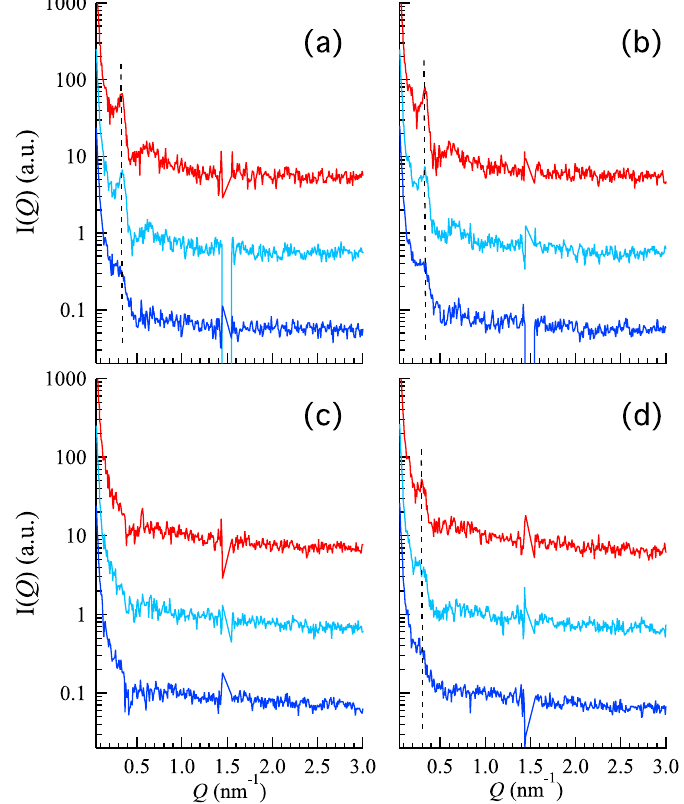
Figure 3. Small angle X-ray scattering (SAXS) di ff raction profiles of P ( a ); P-CA ( b ); P-HA ( c ); and Figure 3. S mall angle X-ray scattering (SAXS) diffraction profiles of P ( a ); P-CA ( b ); P-HA ( c ); and P- P-HA-CA ( d ) at 20 (blue), 30 (light blue), and 37 (red) ◦ C. The dashed line indicates the position of the HA-CA ( d ) at 20 (blue), 30 (light blue), and 37 (red) °C. The dashed line indicates the position of the first correlation peak. Experiments were performed in Graz (AT) first correlation peak. Experiments were performed in Graz (AT) laboratory.